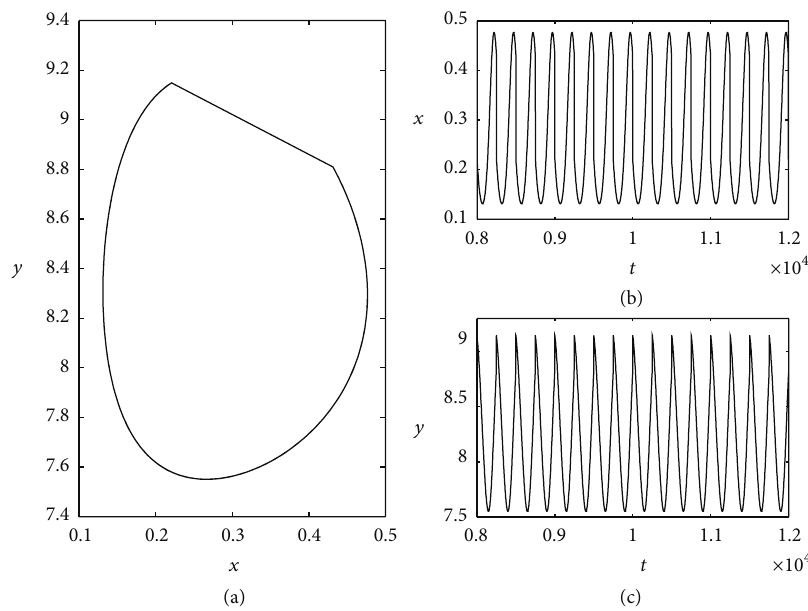
Figure 4: A typical periodic solution of model (24) over 𝑡 ∈ [8000, 12000] . (a) Phase portrait of 𝑥 and 𝑦 with 𝑡 , (b) Time series of 𝑥 . (c) Time series of 𝑦 . The other parameters are identical to those in Figure 2 and 𝑇 = 5 , (𝑥 0 , 𝑦 0 ) = (0.3, 7.3)